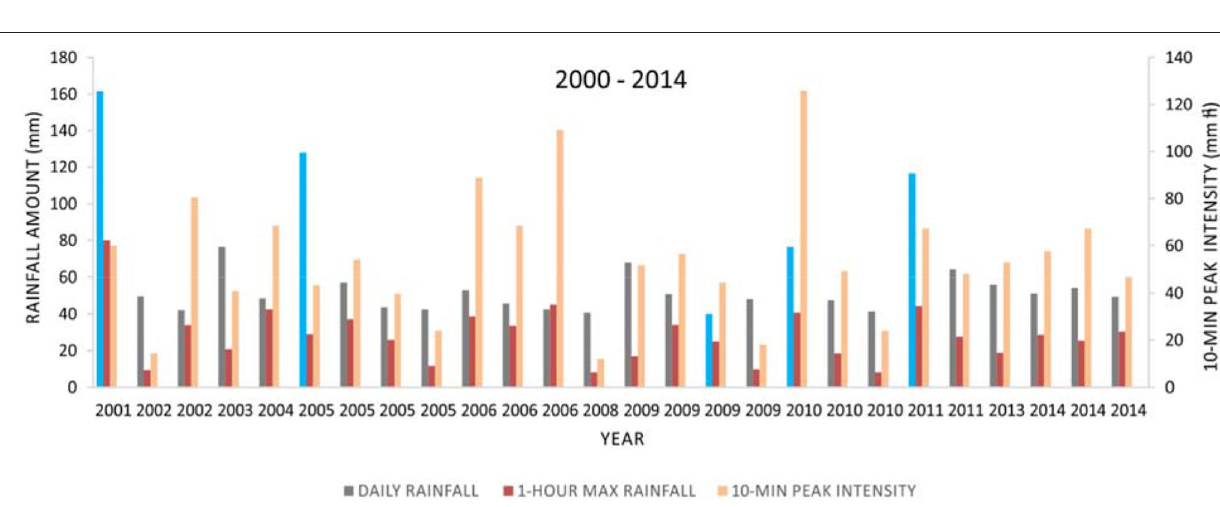
and other damages typical of flash floods, as testified by the example of the oldest event noticed to (i.e., the 1918